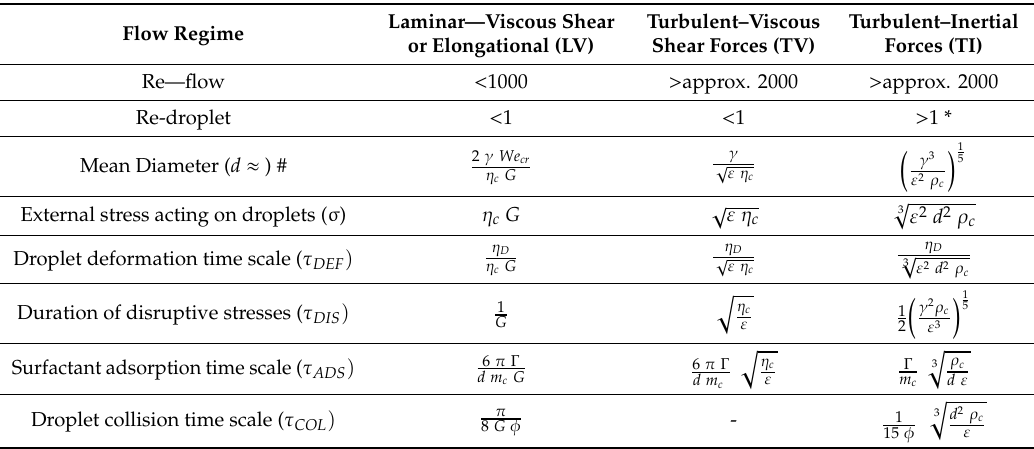
Table 2. Equations for estimating stresses exerted on droplets, expected mean particle diameters, adsorption times of surfactants, droplet deformation times, and collision times for emulsion droplets under laminar and turbulent flow